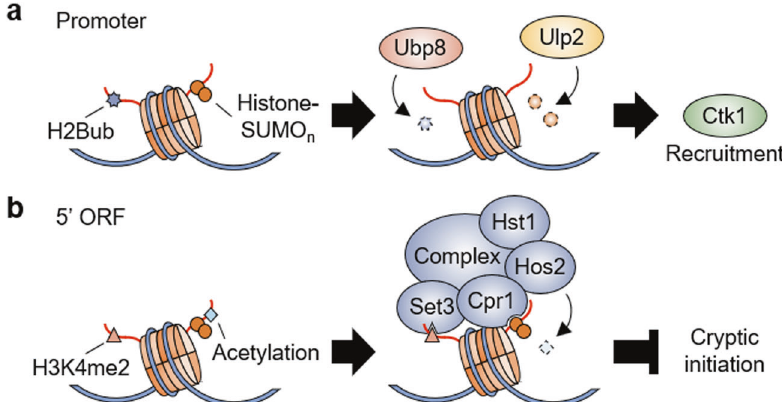
Fig. 3 Dual functions of histone sumoylation in transcription. a In the promoter region, the elimination of ubiquitin and SUMO from histones by Ubp8 and Ulp2, respectively, recruits Ctk1 to chromatin to facilitate the transition between transcriptional initiation and elongation. b In the 5 ′ ORF region, H3K4me2 and histone (poly)sumoylation individually provide binding platforms for Set3 and Cpr1 in the Set3 complex, including two HDAC enzymes, Hst1 and Hos2, to suppress internal cryptic